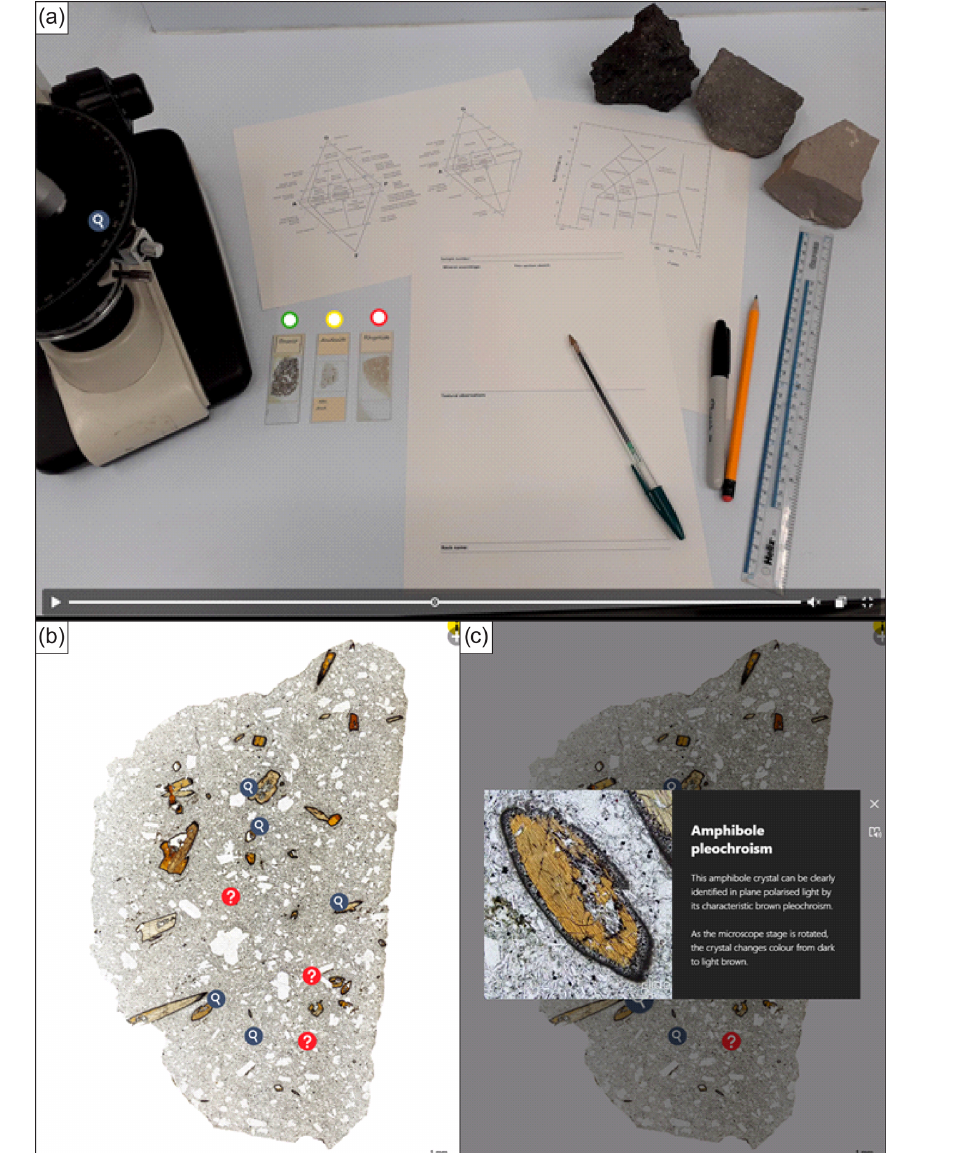
Figure 2. Images taken from the Thinglink-based learning resource created for, and utilized by, this study. (a) The title page of the learning resource designed to mimic a typical workstation for a petrography student. (b) An example high-resolution thin-section image with multiple clickable hotspots. (c) An example of a text and video description which can be activated by clicking on a